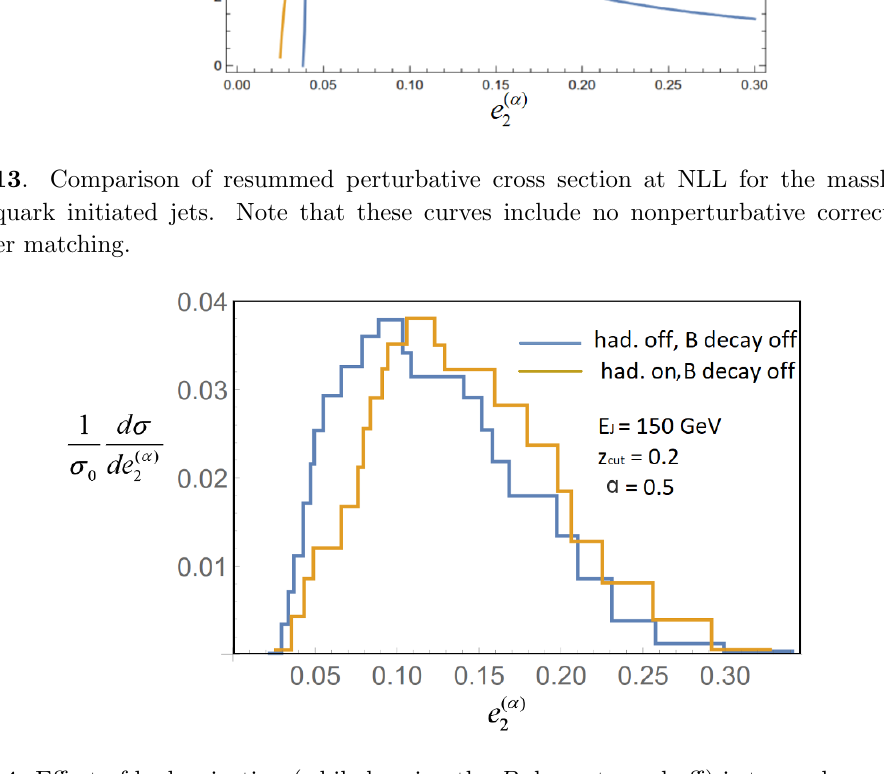
Figure 14 . E(cid:11)ect of hadronization (while keeping the B decay turned o(cid:11)) is to produce a shift in the e ( (cid:11) )